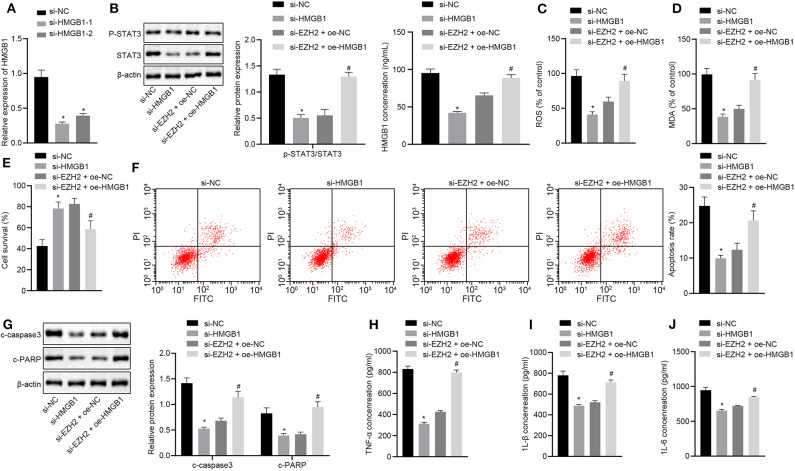
EZH2-mediated methylation of STAT3 enhances ox-LDL-induced injury in HUVECs by activating p-STAT3/HMGB1. (A) Interference efficiency of HMGB1 in HUVECs measured by ELISA. HUVECs were treated with siRNA targeting HMGB1 (with si-NC as control) or siRNA targeting EZH2 and expression vectors containing HMGB1 (with si- EZH2 + oe-NC as control). (B) Protein levels of p-STAT3/STAT3 in HUVECs determined using Western blot analysis, normalized to β-actin, and HMGB1 level determined by ELISA. (C) ROS levels in HUVECs measured with the ROS Assay Kit. (D) MDA levels in HUVECs measured with the ROS Assay Kit. (E) Cell viability of HUVECs detected by CCK-8 assay. (F) Apoptosis of HUVECs detected by flow cytometry. (G) Protein levels of cleaved-caspase3 and cleaved-PARP in HUVECs determined by Western blot analysis, normalized to β-actin. (H–J) Concentration of TNF-α, IL-1β, and IL-6 in the culture supernatant of HUVECs measured by ELISA. *(relative to scramble siRNA-treated HUVECs) and #(relative to siRNA-targeting EZH2-treated HUVECs) indicate p < 0.05 by one-way ANOVA/Tukey's post-hoc test.